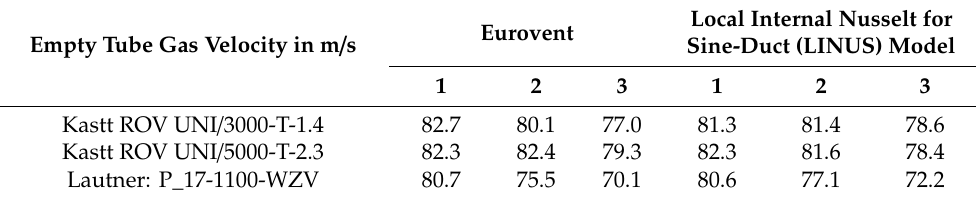
Table 6. Temperature e ff ectiveness: Eurovent and simulation with proposed model.